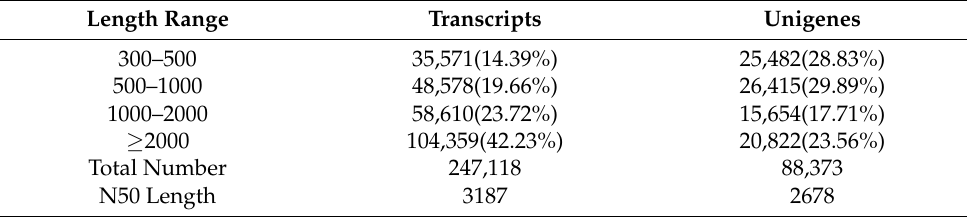
Table 1. Assembly of S. tenuifolia transcripts and